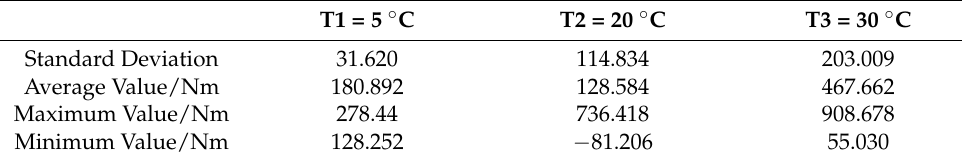
Table 6. Influence of Ambient Temperature on Engine NOx Raw Emission.